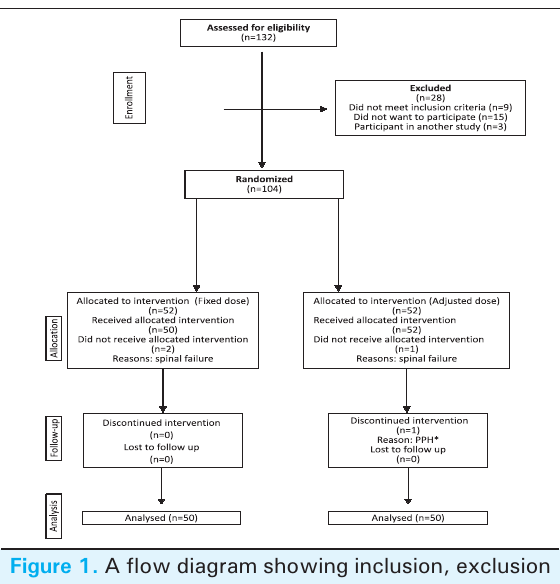
Figure 1. A fl ow diagram showing inclusion, exclusion and randomization of